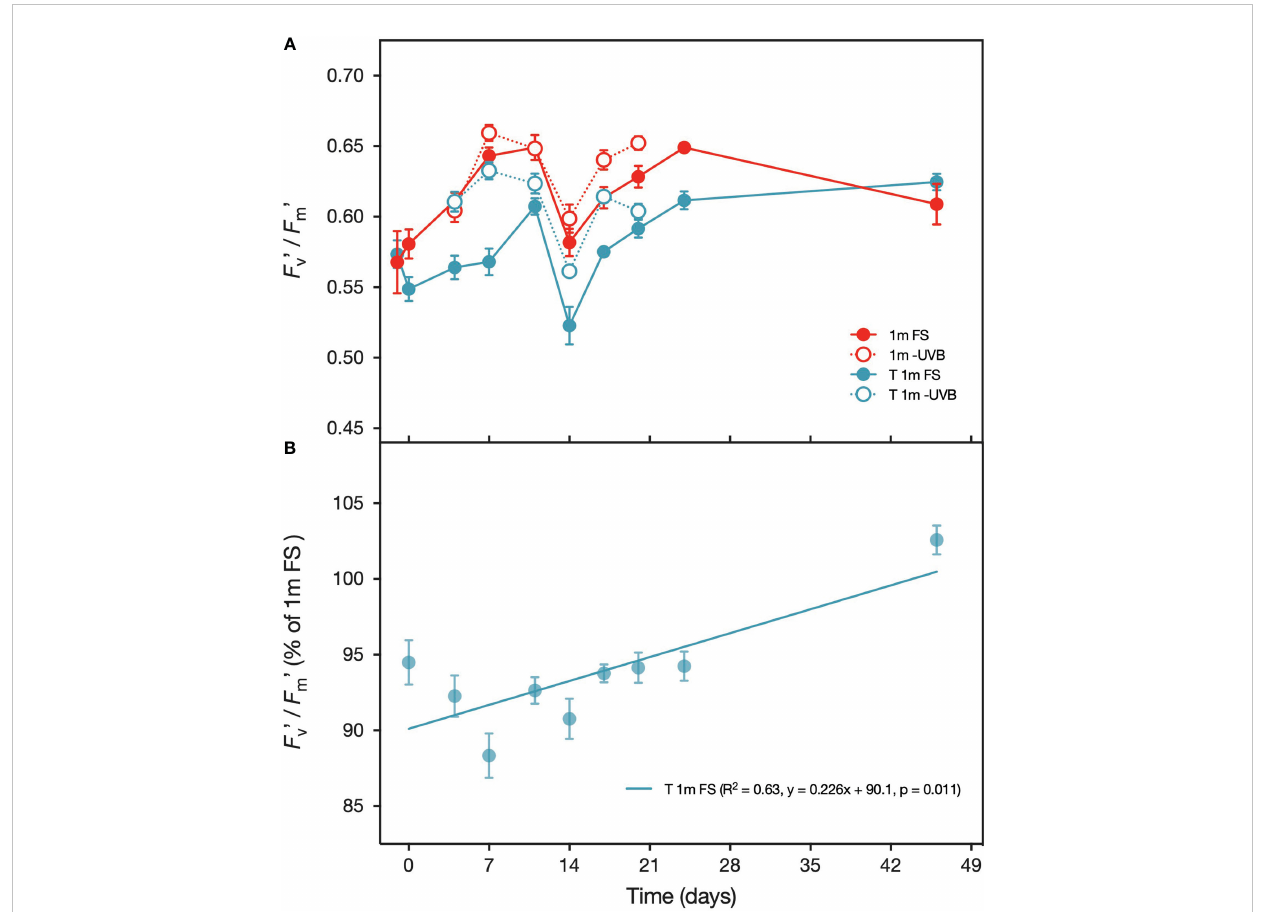
FIGURE 7 (A) Effective quantum yield ( F v ’ / F m ’ ) of Pocillopora verrucosa fragments from 1 m (red) and T 1m (transplanted from 5 m) (blue) exposed to either full sunlight ( fi lled circles) or with UVB-removed (open circles) during the transplantation experiment performed between 2 nd May – 16 th June 2019. Also displayed is the F v ’ / F m ’ of colonies in situ on the day before the experiment (T = -1 days). (B) Effective quantum yield ( F v ’ / F m ’ ) of T 1 m (transplanted from 5 m) Pocillopora verrucosa specimens under FS, displayed as percentage of the F v ’ / F m ’ of the FS corals kept at their original sampling depth (1 m). Values are means (n=10) ±